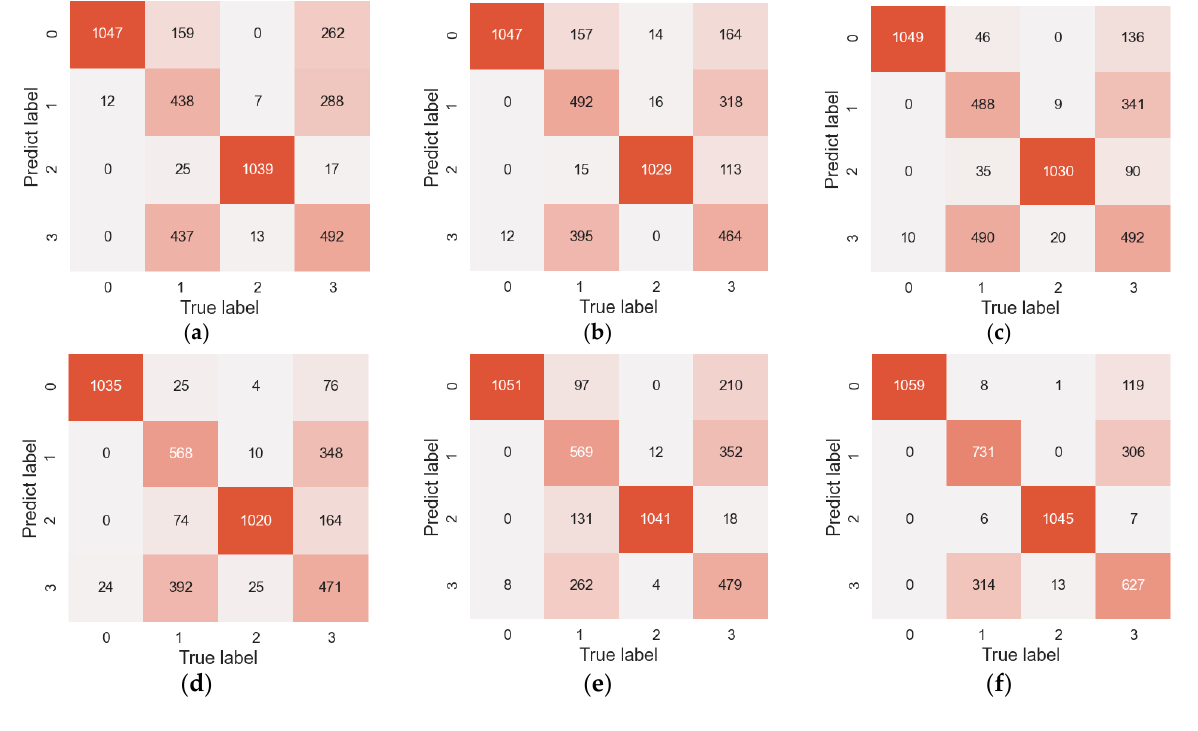
Figure 8. Confusion matrix of experiment 14. ( a ) SAE-SSL; ( b ) π -Model; ( c ) DNN-SSL; ( d ) VAE-M1; ( e ) MRAE; ( f ) MRAE-AG.